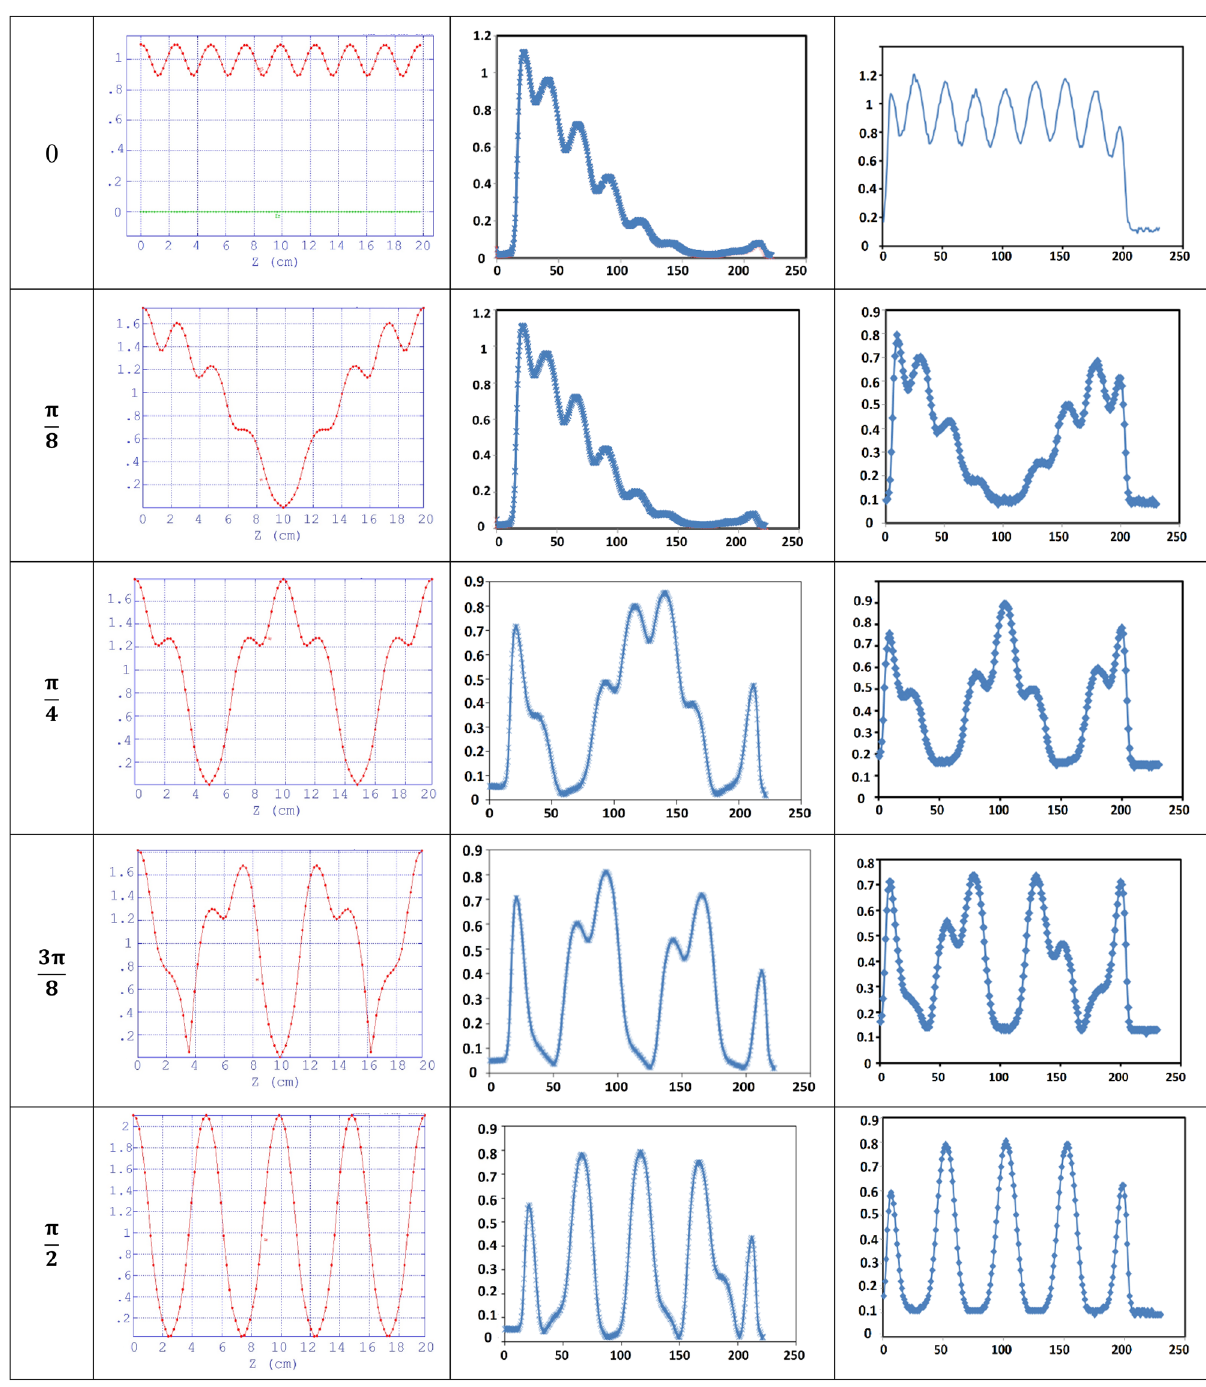
Figure 14. On-axis electric field for different modes (0–π from up to down with step π/8). Left: superfish simulation, middle: before tuning, right: after